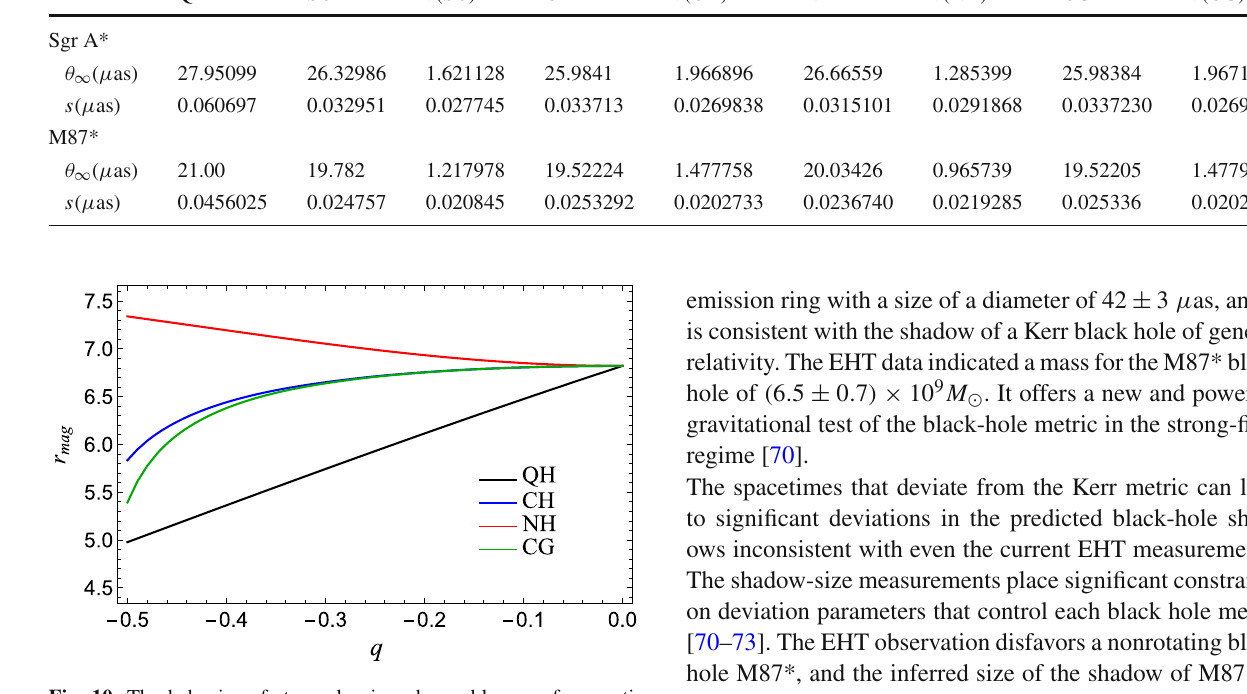
Fig. 10 The behavior of strong lensing observable r mag for quartic Horndeski black holes (QH), charged Horndeski black holes (CH), Horndeski black holes (NH) and charged Galilleon black holes (CG). The parameter q is q e , γ and (cid:19) for charged Horndeski black holes, Horndeski black holes and charged Galilleon black holes,